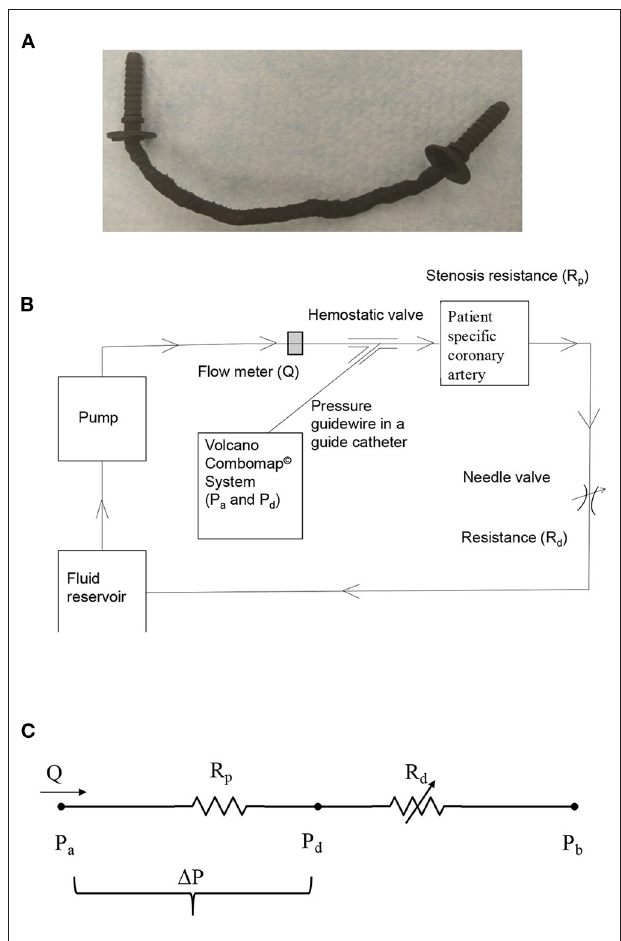
FIGURE 1 | (A) 3D printed patient-specific LAD coronary artery; (B) schematic of in vitro coronary flow-loop setup for FFR 3D ; and (C) electrical analog model of the flow-loop with two resistances in series. R p , stenosis resistance from the 3D printed model; R d , coronary microvascular resistance; Q, flow through stenosed artery measured by the flowmeter; P a , aortic pressure; P d , pressure distal to the stenosis; 1 P = P a -P d , pressure-drop across stenosis; P b , coronary outflow